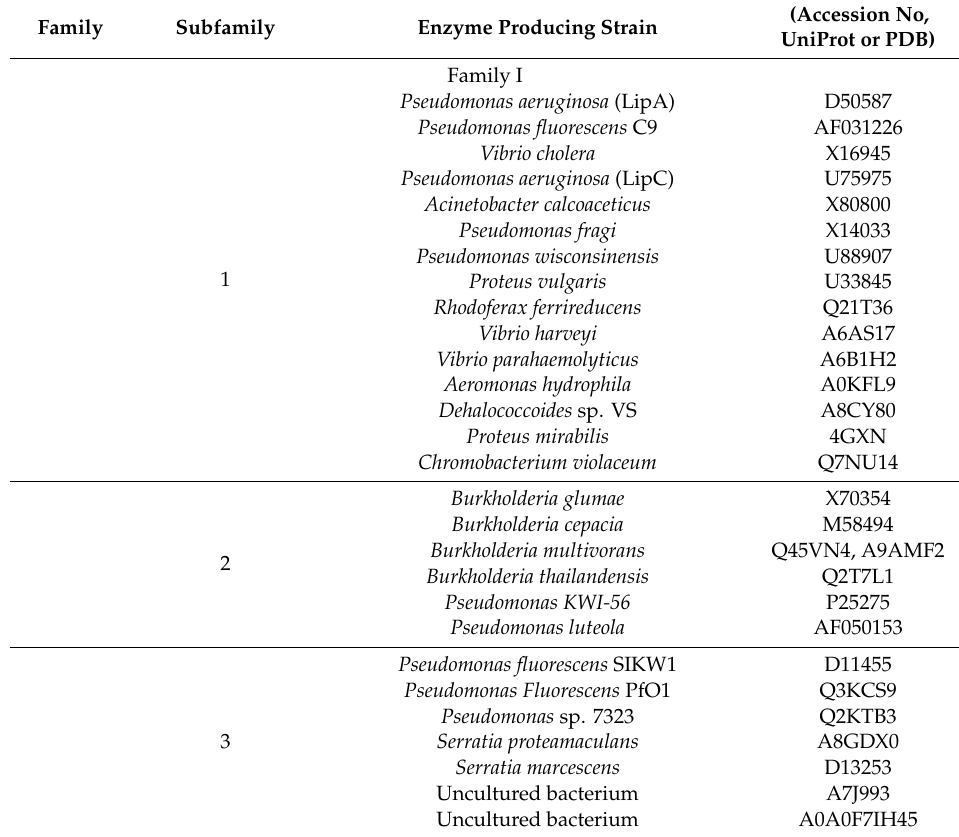
Table 1. Current classification of bacterial lipolytic enzymes retrieved from UniProt database & GenBank,